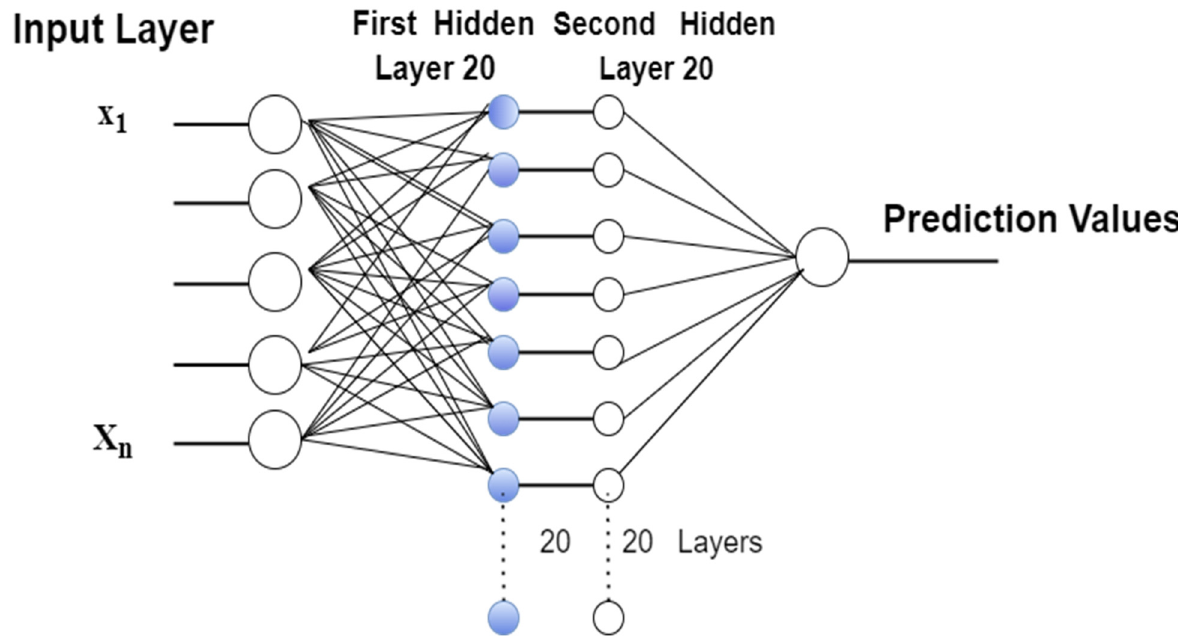
Figure 3. MLP structure to predict the stock market.